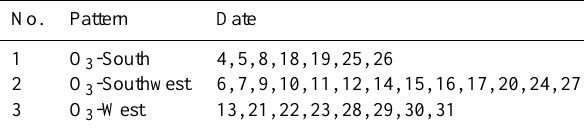
Table 4. Classification of O 3 pollution days into three evolution patterns in the PRD during 4–31 October 2004.